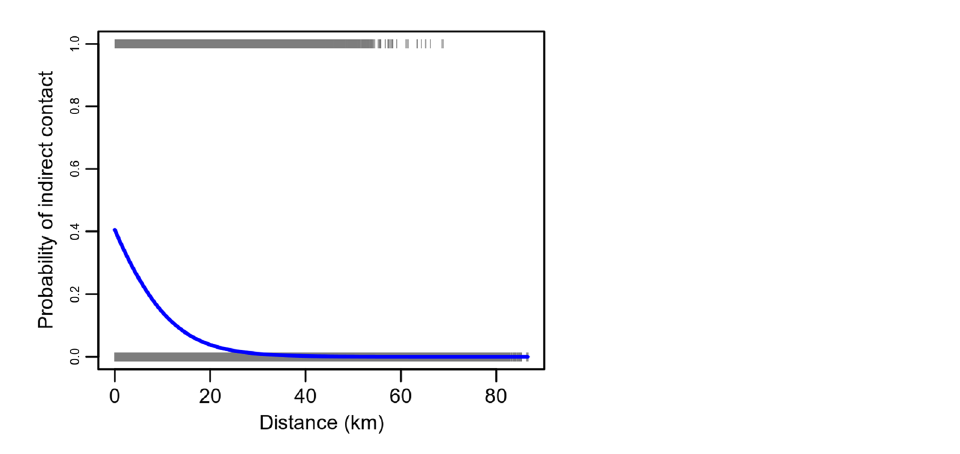
Figure 4. Probability of indirect contacts vs. distance. Logistic regression model for indirect contacts ( h = 14 days) vs. distance. The grey bar represents the observed contacts, the blue line the fitted